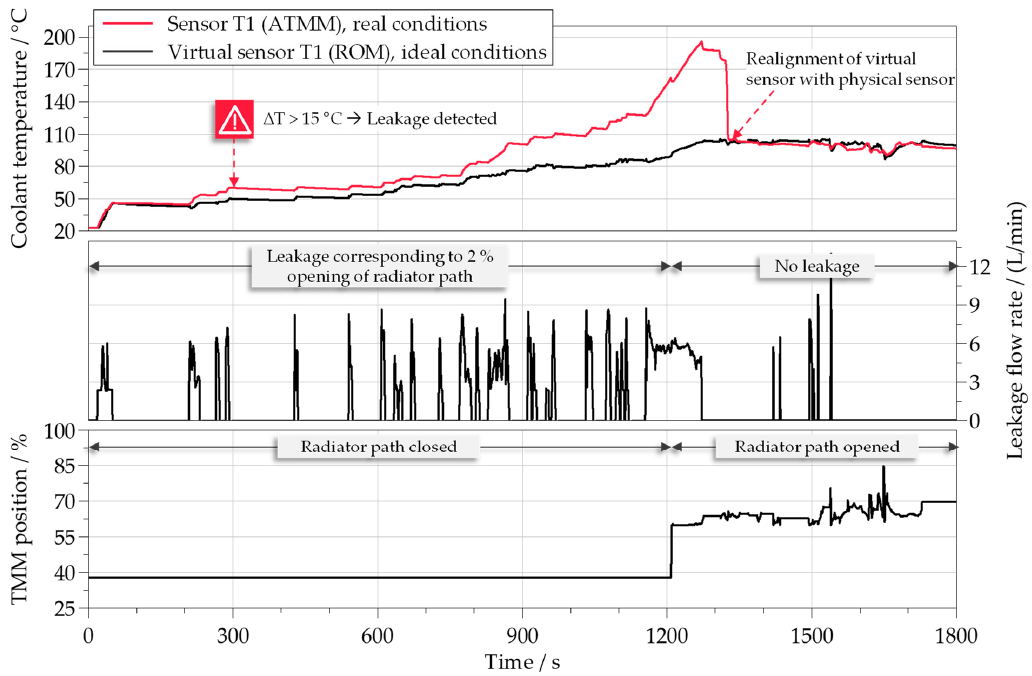
Figure 16. Demonstration of failure mode detection for TMM radiator path leakage in